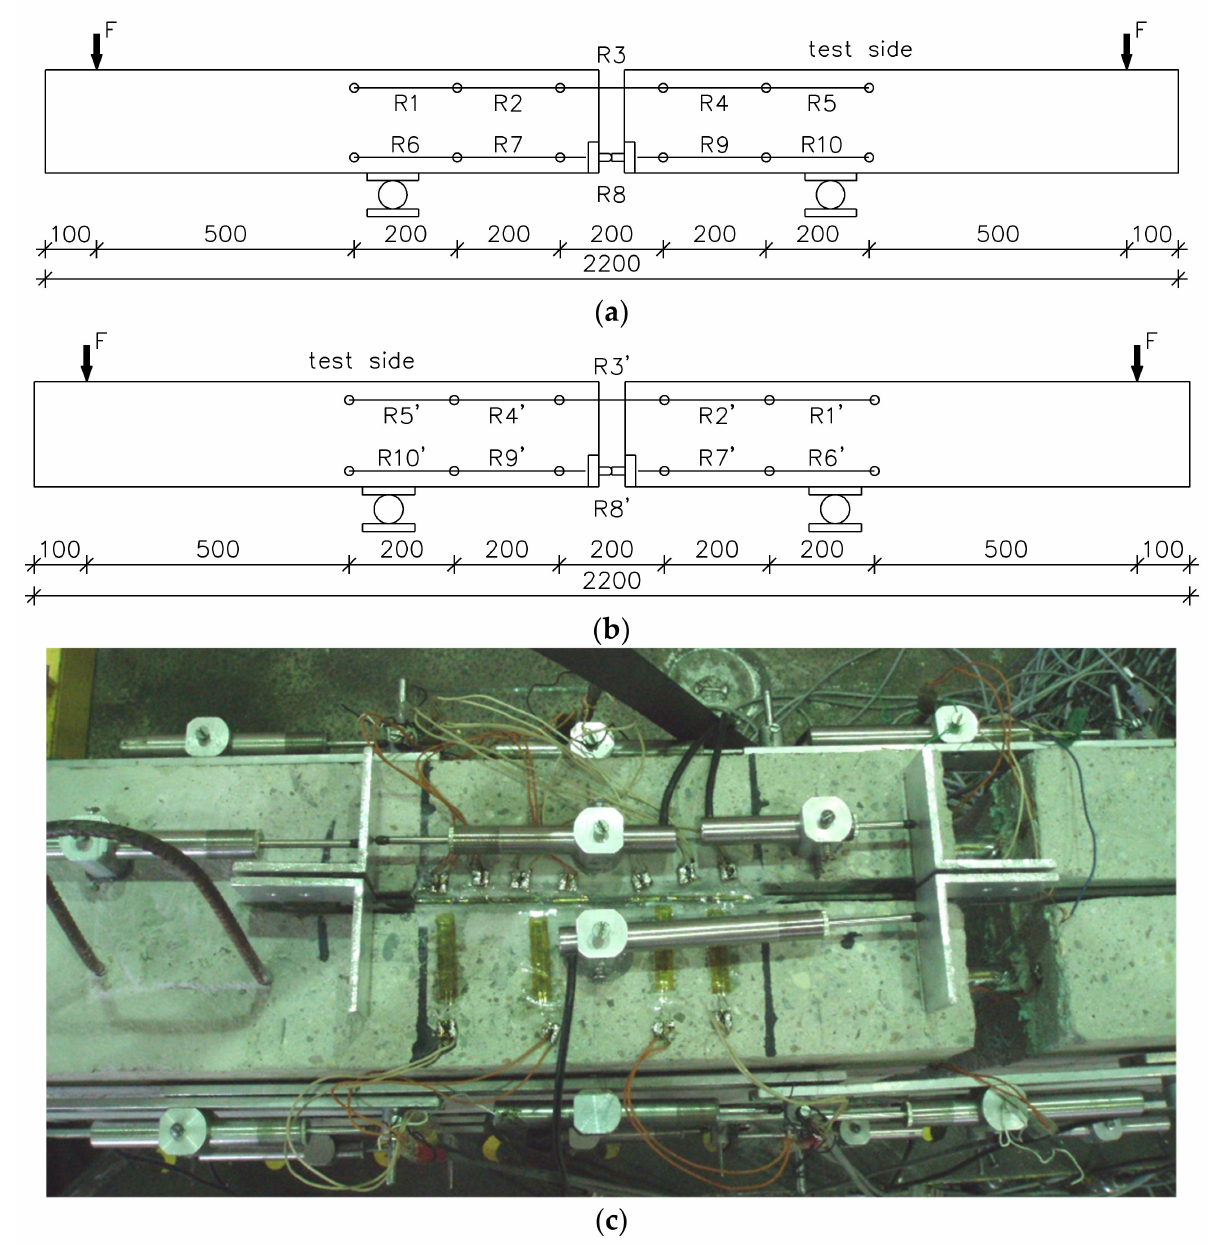
Figure 3. Location of strain measurements (dimensions in mm): ( a ) axial strains in compression and tension on the test site and ( b ) opposite site; ( c ) strain gauges bonded to the concrete and CFRP strip with LVDTs at the end-bond slip measurements on loaded and free CFRP strip